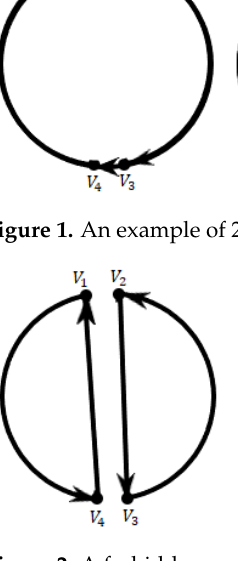
Figure 2. A forbidden movement resulting in closed circuits